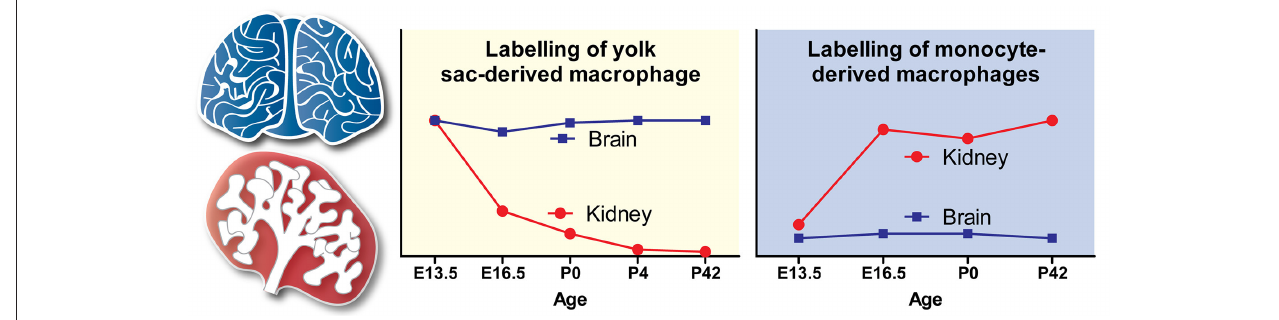
FIGURE 2 | Contribution of yolk sac-derived and monocyte-derived macrophages to the embryonic and postnatal kidney. The trends shown in the yolk sac-derived and monocyte-derived macrophage graphs are based on fate-mapping experiments by Hoeffel et al. (2015). Trends for the origins of brain macrophages (microglia), which are yolk sac-derived, are shown as a comparison. Adapted with permission from Hoeffel et al. (2015).